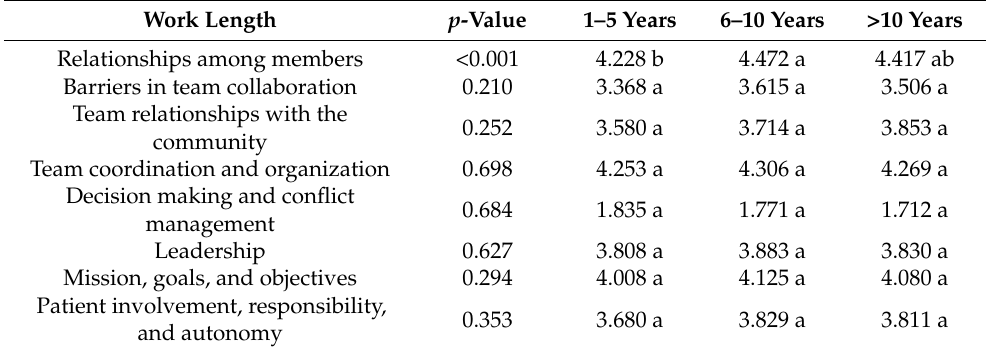
Table 2. Reported CPAT scores categorized by work length (N = 261 − N HUH = 98; N BRPH = 96, N HGH =